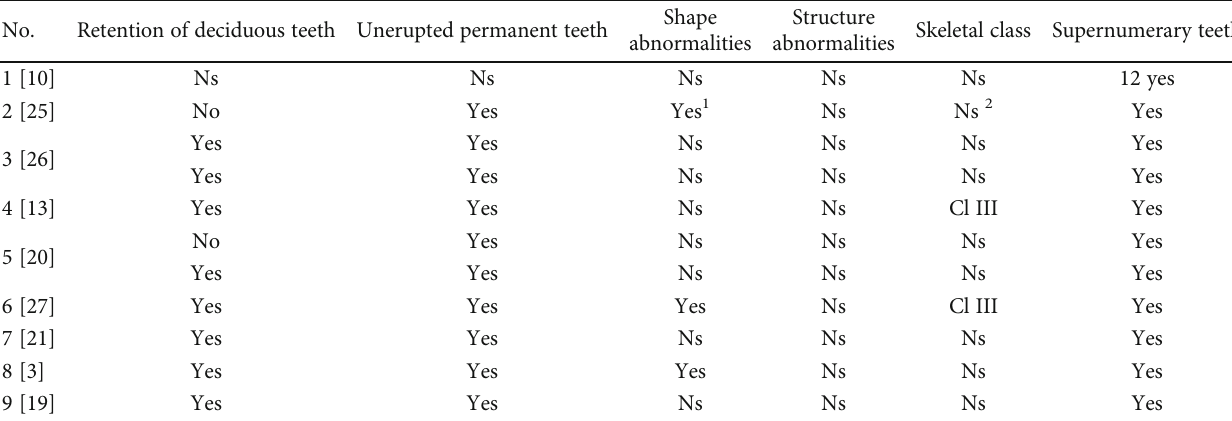
Table 2: Dental features of the patients included in the systematic review.